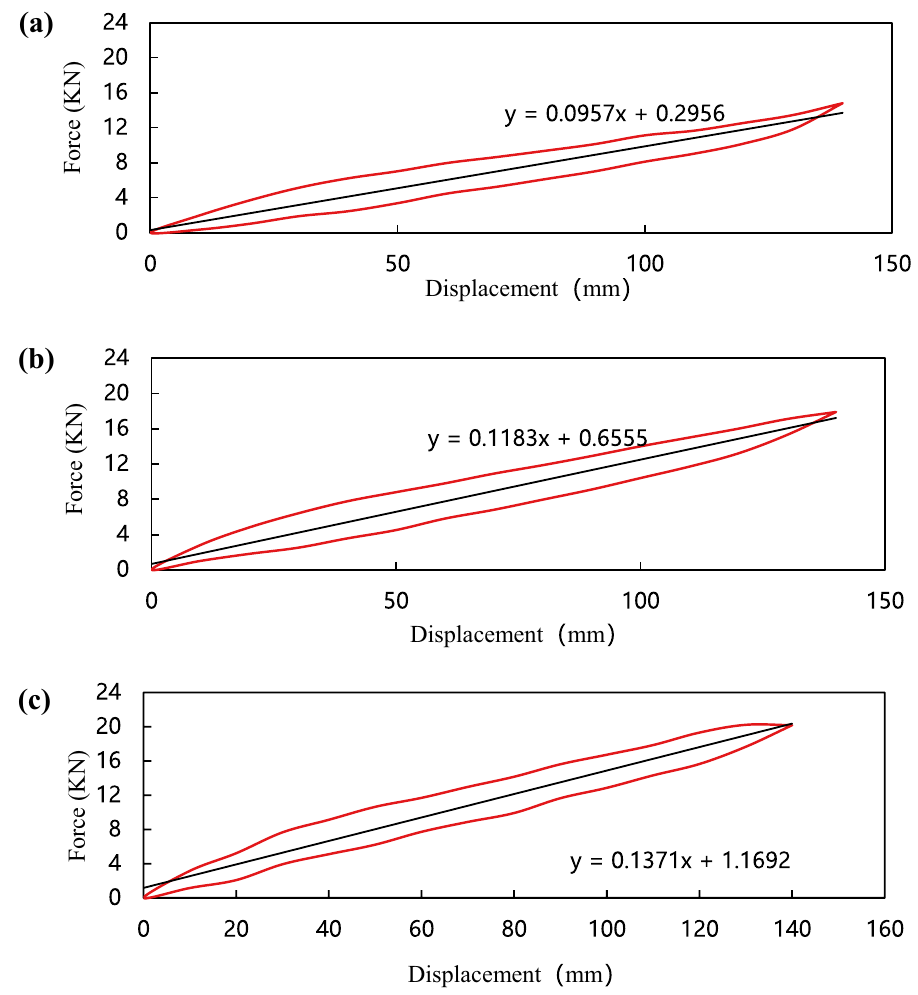
Figure 6. Stiffness curve of composite leaf spring with different fiber volume content; ( a ) specimen 4 test data; ( b ) specimen 1 test data; ( c ) specimen 5 test data.